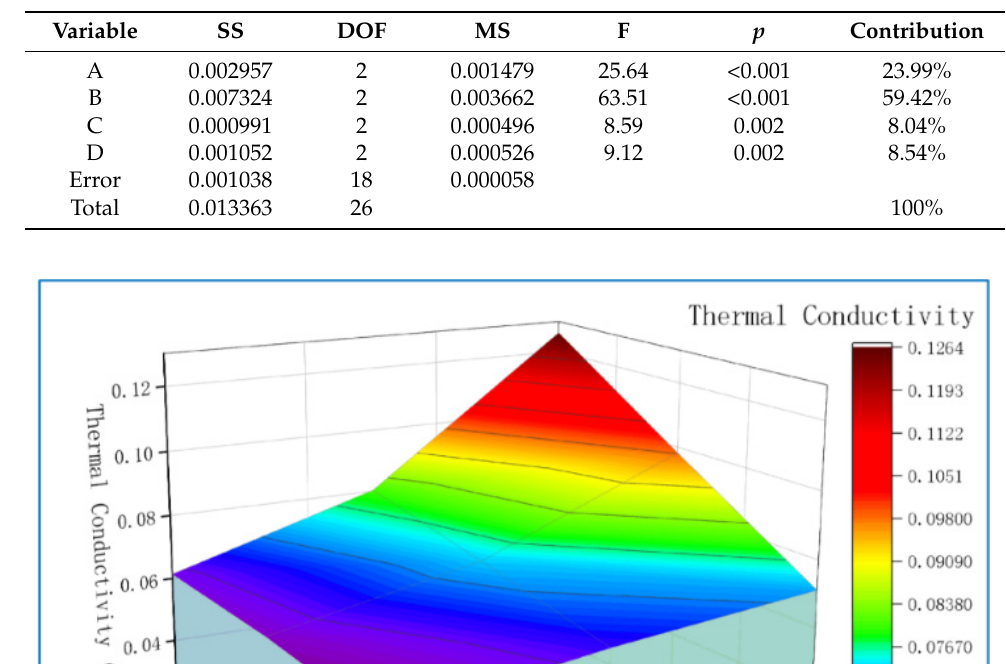
Table 7. Range analysis of tensile